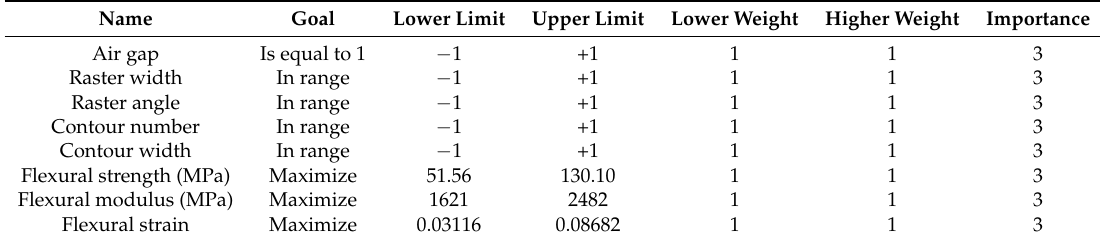
Table 4. Constraints of factors and responses used for the